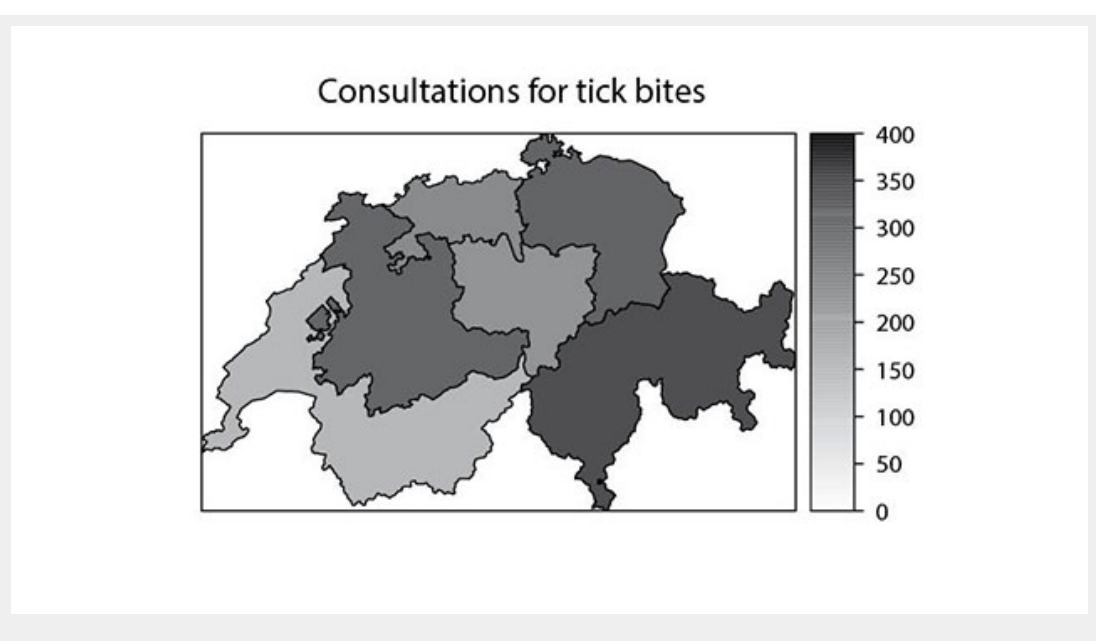
Geographic distribution by Sentinella Regions regarding treated tick bites, Lyme borreliosis and tick borne encephalitis, Switzerland 2008 to 2011. Panel 1: Treated tick bites, yearly incidence per 100,000 inhabitants, 2008–2011.